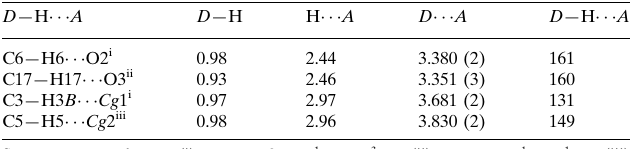
Hydrogen-bond geometry (A˚ , (cid:1)